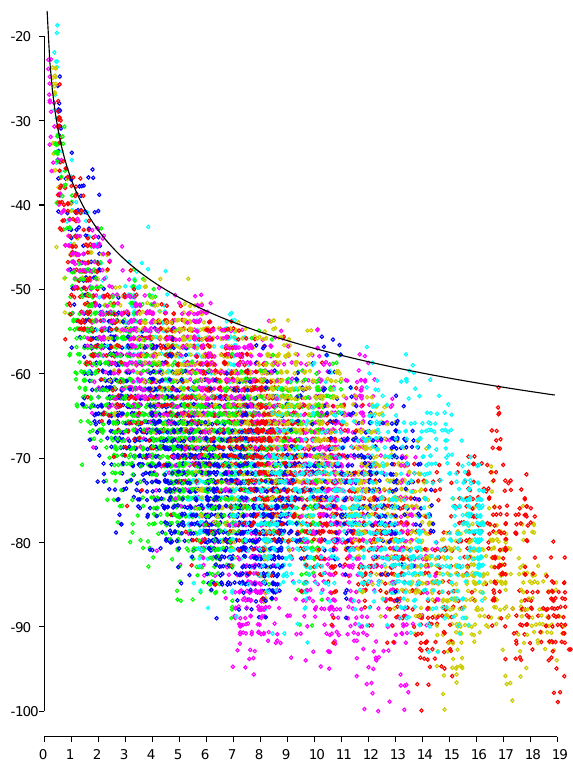
Figure A1. Scattergram of signal strength (vertical axis—dBm) versus actual distance (horizontal axis—meters) in typical house based on about 10,000 measurements. Results from six responders color coded. Solid curve is inverse square law